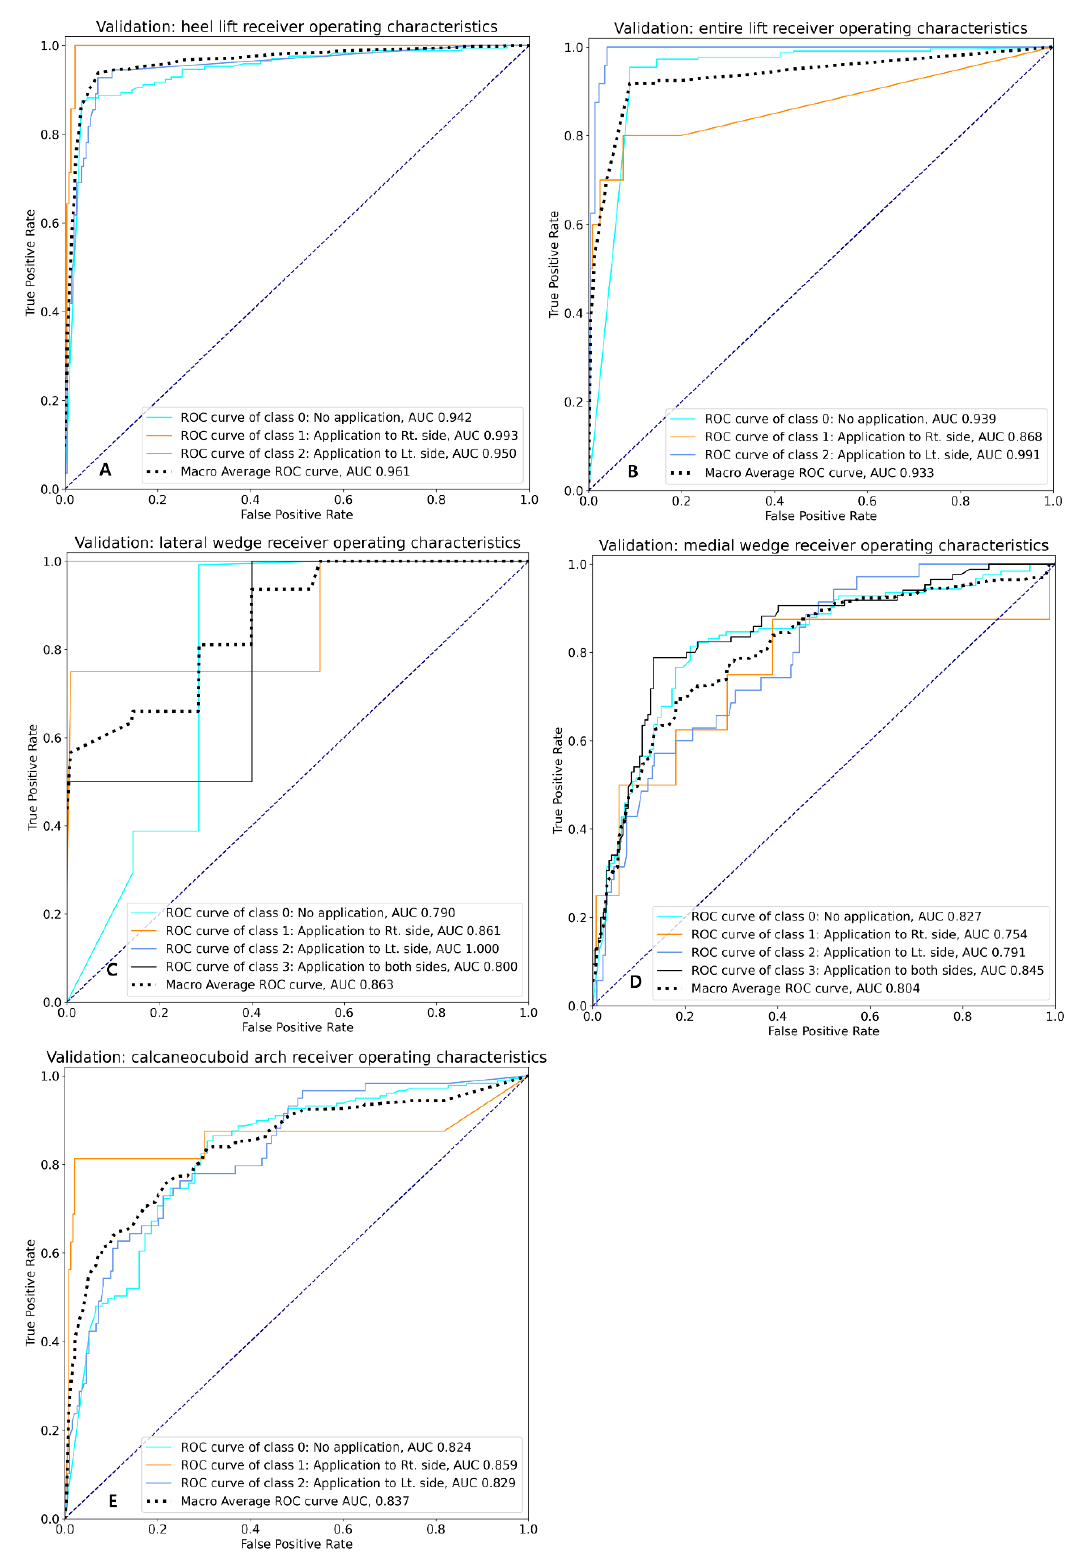
Figure 3. Receiver operating characteristic curve of the validation dataset of the deep-learning models for the prescription of orthotic insoles. ( A ) heel lift ( B ) entire lift ( C ) lateral wedge ( D ) medial wedge ( E ) calcaneocuboid arch.